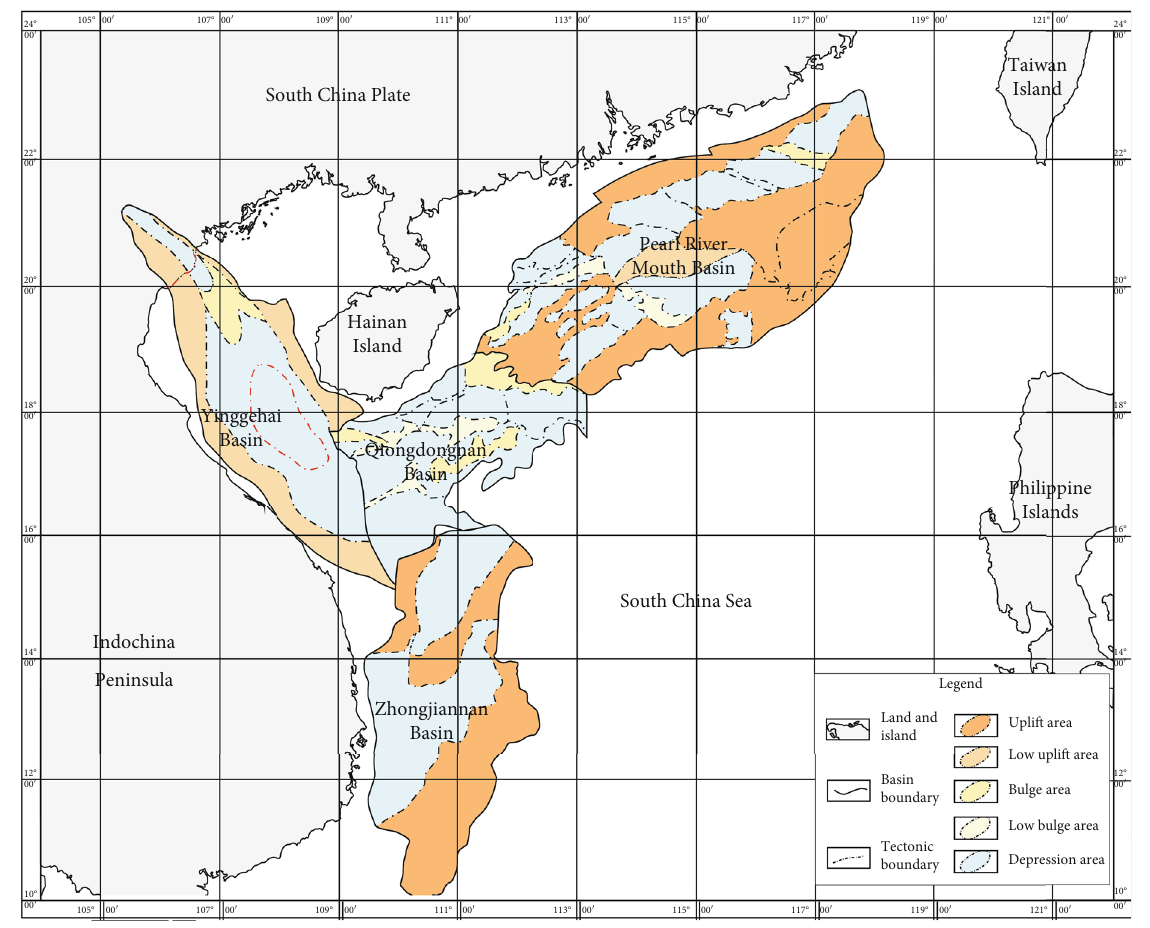
Figure 1: Study area distribution map (modi fi ed from Zhu et al.)